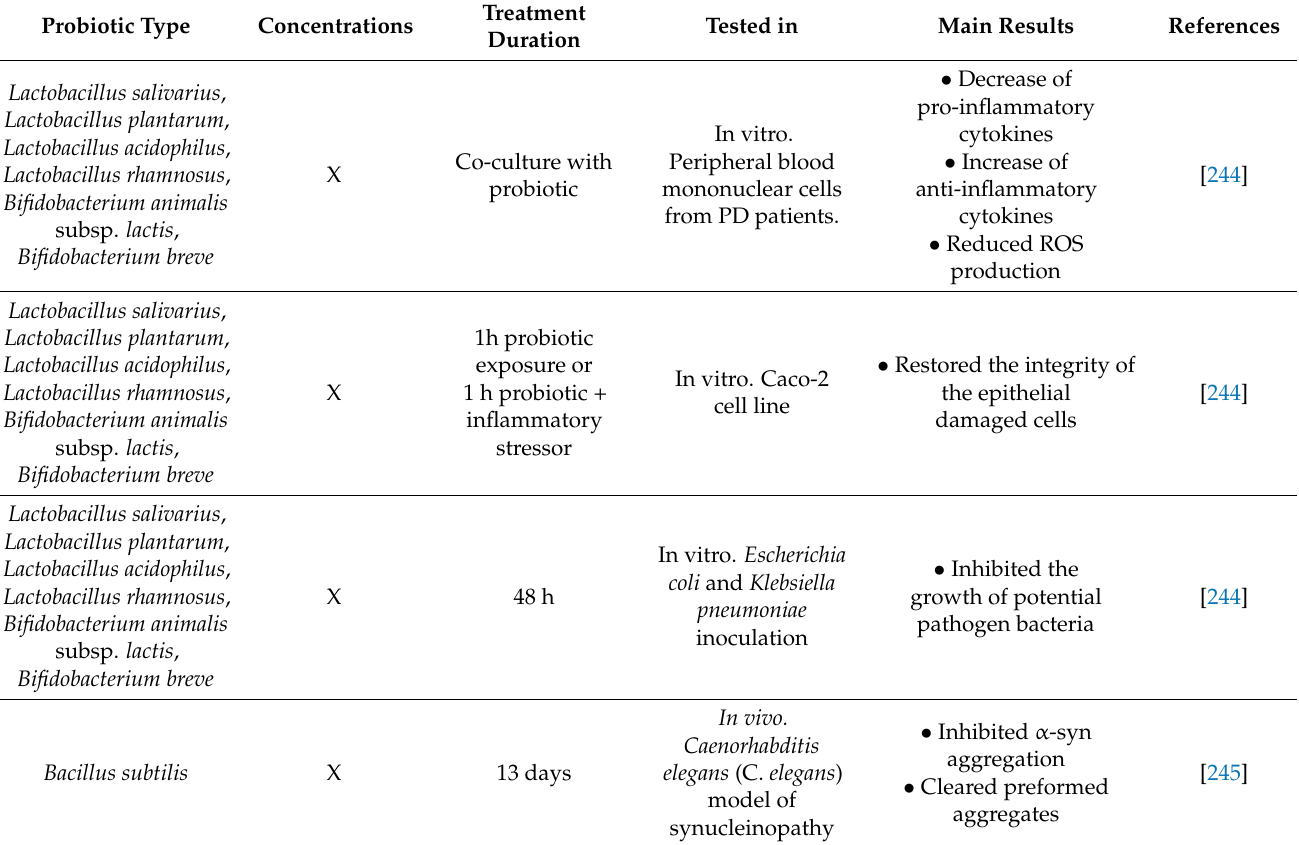
Table 3. Neuroprotective effects of probiotics on pathological features of